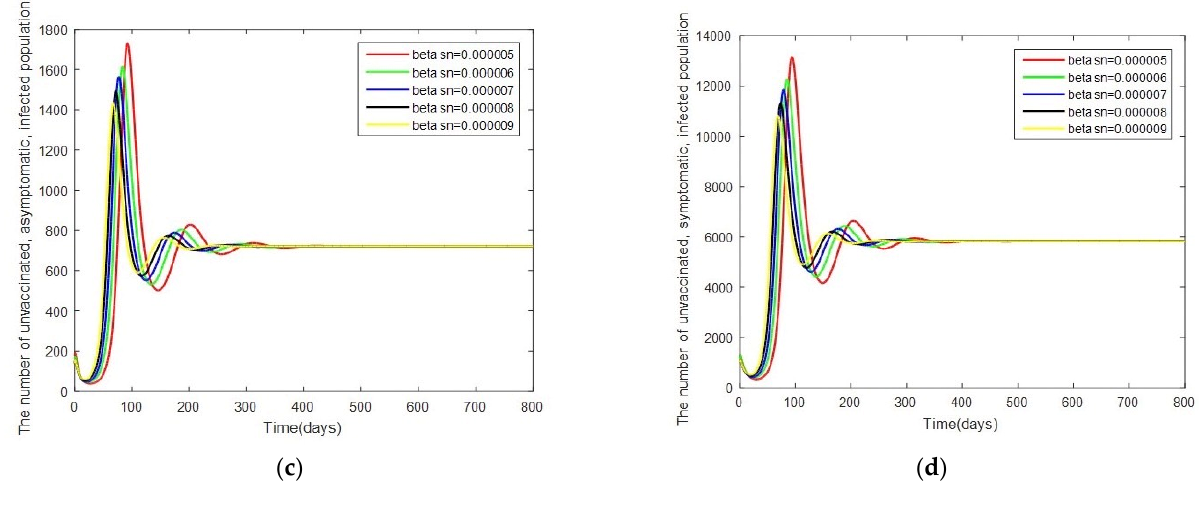
Figure 7. Graphs of the system of Equations (3)–(12) showing the comparison results of the infection rate of the symptomatic, unvaccinated, infected population ( β sn ) when R 0 > 1: ( a ) the number in the unvaccinated, susceptible population; ( b ) the number in the unvaccinated, exposed population; ( c ) the number in the unvaccinated, asymptomatic, infected population; and ( d ) the number in the unvaccinated, symptomatic, infected population.